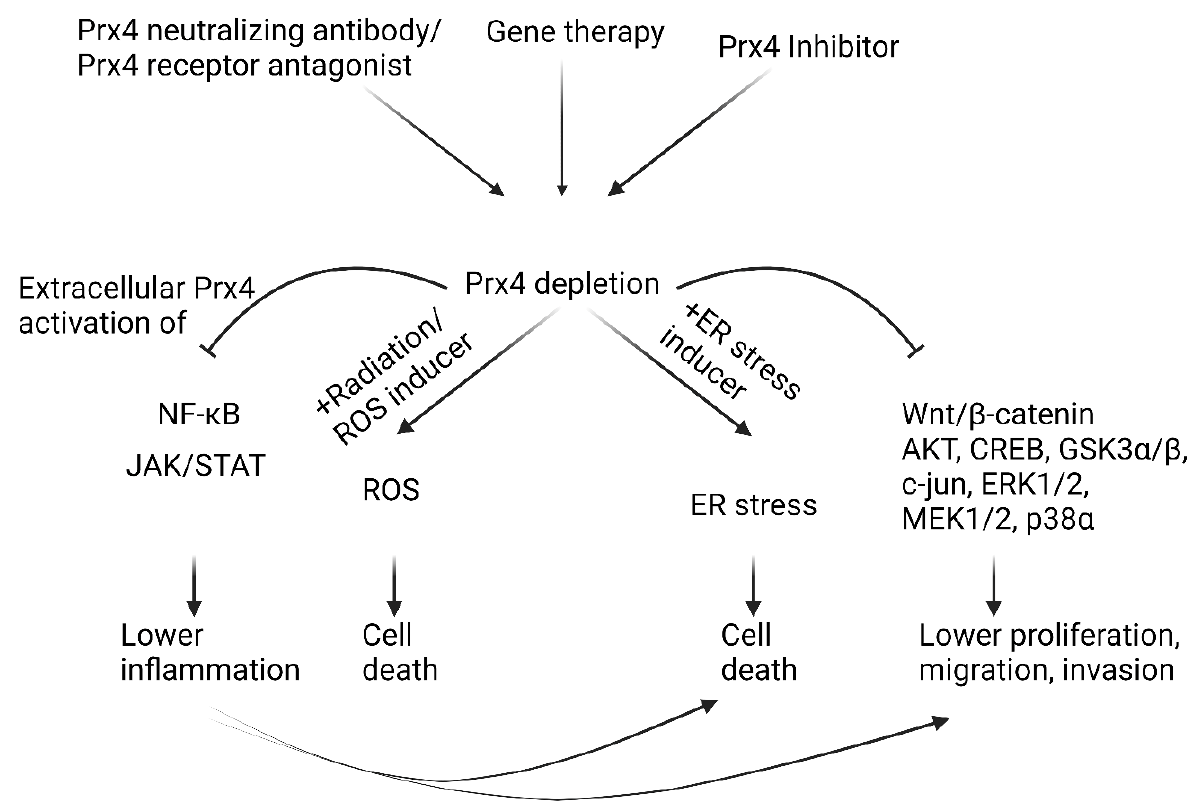
Figure 6. Depletion of Prx4 as a therapeutic approach for cancer treatment.